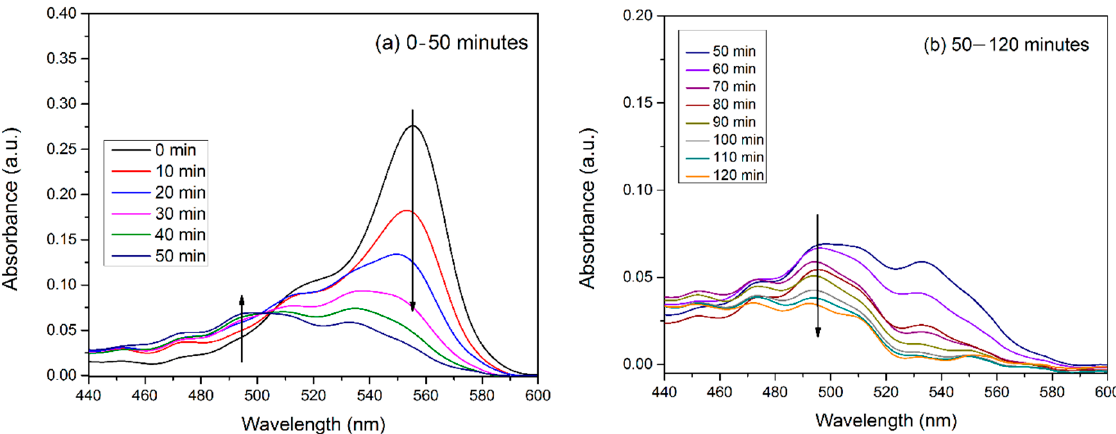
Figure 12. The absorption spectrum evolution during photocatalytic RhB degradation with emphasis on the RhB degradation byproducts corresponding to absorbance peaks.